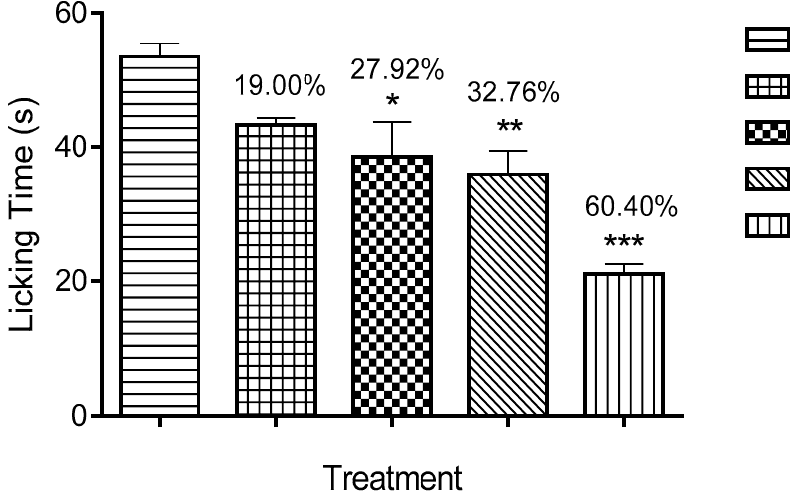
Figure 4. E ff ect of MEDL on capsaicin-induced nociception in mice. Each column represents the mean ± SEM of six mice. Statistical analyses were performed using 1-way ANOVA followed by Tukey’s multiple comparisons test. * p ≤ 0.05, ** p ≤ 0.01 and *** p ≤ 0.001 compared to vehicle control group. Values on top of each column denote inhibition.